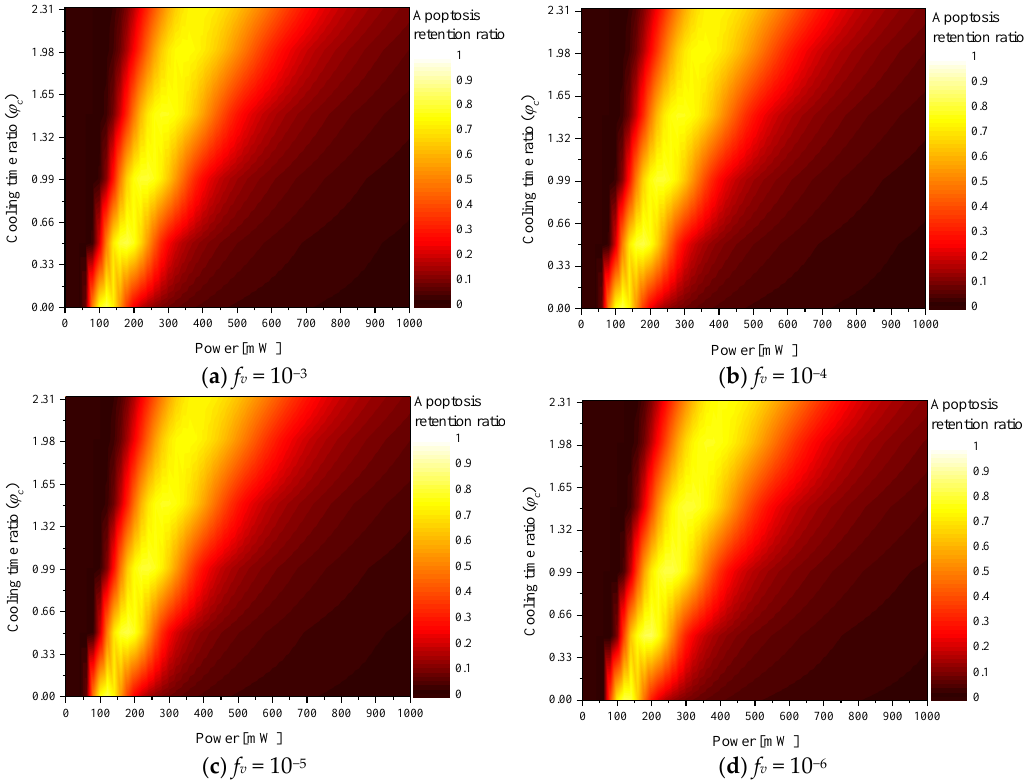
Figure 2. Apoptosis retention ratio ( 𝜃 𝐴∗ ) for various cooling time ratios ( 𝜑 𝑐 ).